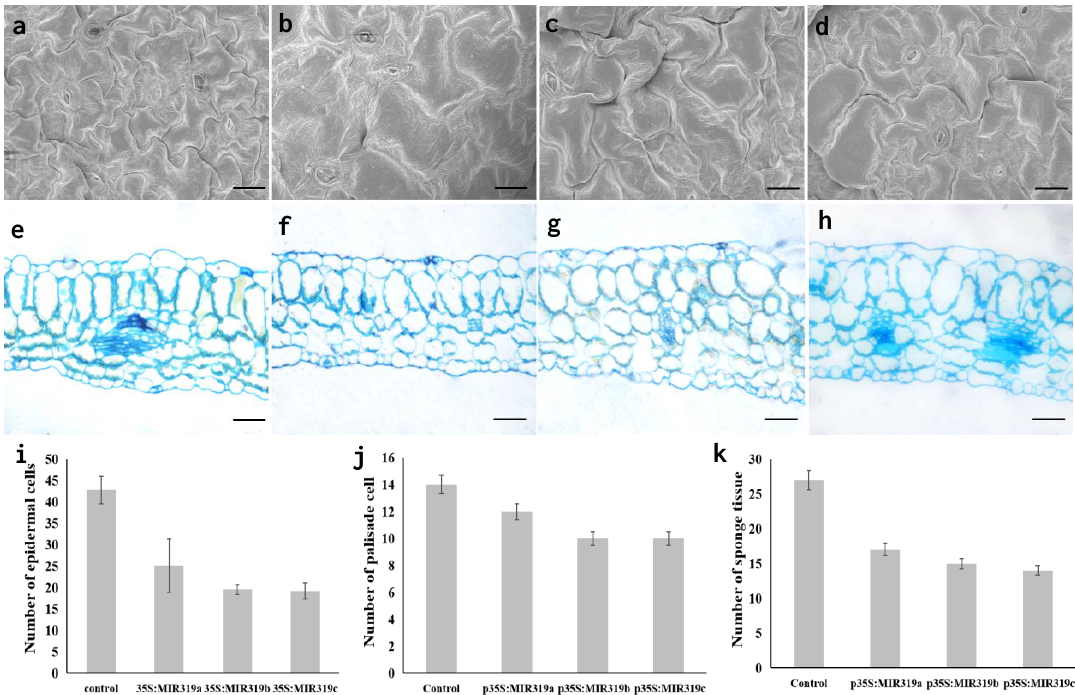
Figure 3. SEM and semithin section observation of leaf cells in transgenic Arabidopsis overexpressing the Bra-MIR319 gene family. ( a – d ) SEM observation of leaf epidermal cell of wild-type plants and Bra-MIR319 family transgenic Arabidopsis , respectively. ( e – h ) Observation of leaf structure of wild-type plants and Bra-MIR319 family transgenic Arabidopsis , respectively, via semithin section analysis. ( i – k ) Statistical analysis of leaf epidermal cells, palisade tissue, and sponge tissue cells under 1 K magnification. Scale bars, 50 μm.